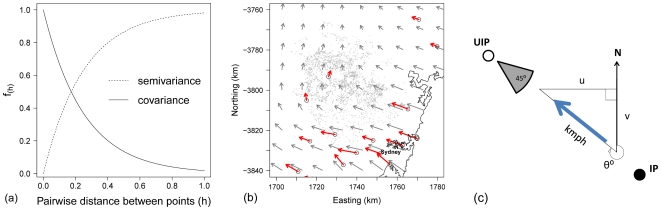
The estimation of premises-level wind speed covariates in a survival analysis of time to infection in the largest cluster of the 2007 outbreak of equine influenza in Australia.(a) Exponential covariance function (with practical range = 0.25) and its related semivariance function. (b) Hourly wind velocity data from sixteen automated weather stations (open circles) within a 20 km buffer of the cluster's boundary were converted into their East-to-West (‘u’) and North-to-South (‘v’) components, and smoothed using kriging to predict hourly wind speed and direction at each premises (small grey dots). (c) For each premises on each day prior to infection or censoring, the (‘directed’) maximum wind speed originating from within 45( arcs centred on the direction of the nearest 1–3 infected premises was estimated for time lags of 1–5 days.